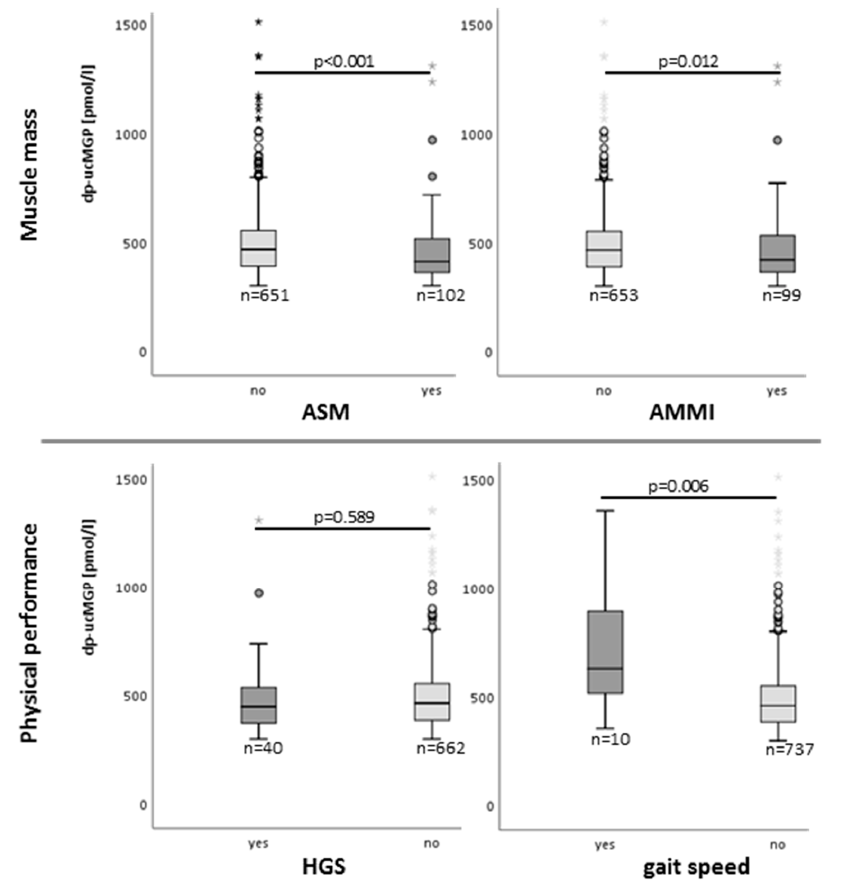
Figure 2. Dp-ucMGP levels in persons with and without reduced muscle mass or physical performance. Dark grey box plots represent the presence of decreased muscle mass or physical performance, whereas light grey boxes represent their absence. Dp-ucMGP: dephosphorylated, uncarboxylated Matrix-GLA-protein; pmol: picomol; L: liters, n: number; ASM: appendicular skeletal muscle mass; AMMI: appendicular skeletal muscle mass index; HGS: handgrip strength. Stars represent high extreme values and light or dark grey dots high potential outliers.